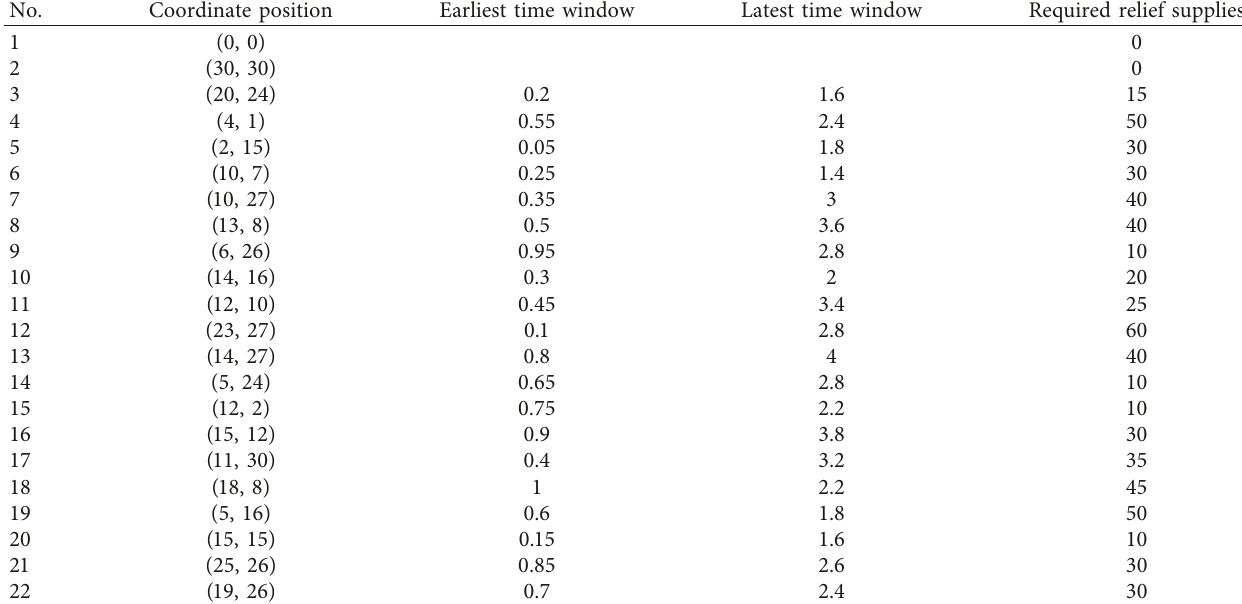
Table 2: Transportation network information